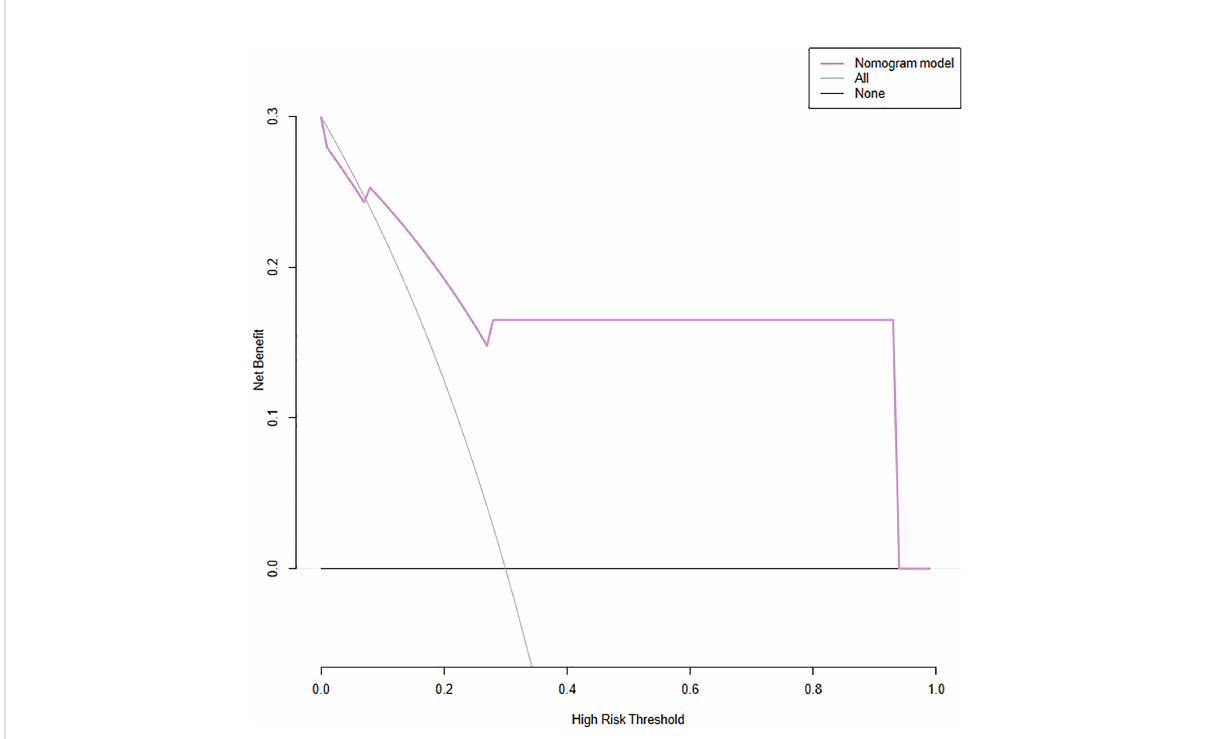
FIGURE 6 Decision curve analysis (DCA) for the nomogram. The y-axis represents the net bene fi t. The x-axis represents the threshold probability, which means that the expected bene fi t of treatment is equivalent to the expected bene fi t of non-treatment, the decision curve shows that the nomogram model (purple line) adds more bene fi t than either the treat-all scheme (grey line) or treat-none scheme (black line) in predicting sentinel lymph node burden when the threshold probability ranges from 16 to 96%.